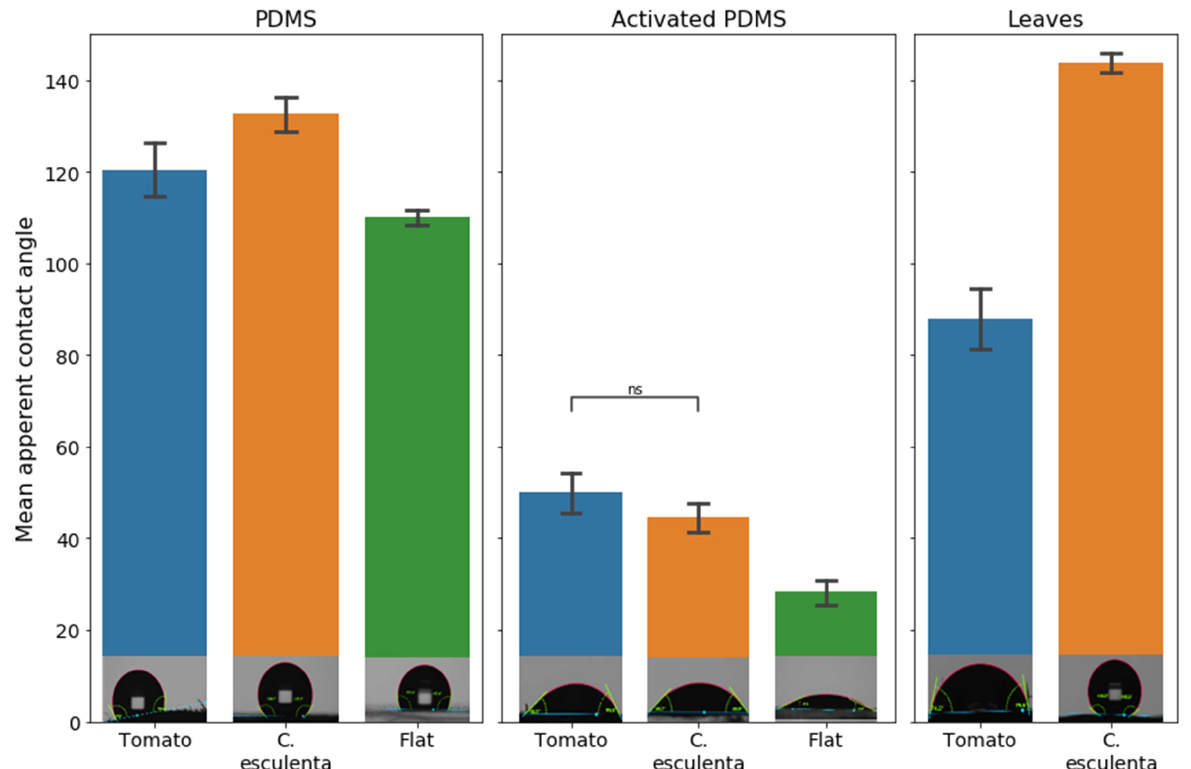
Figure 4. Hydrophobicity measurements of natural and synthetic surfaces. The mean apparent contact angle of synthetic and natural surfaces was measured. The bottom row presents images of the drop in a stable state. The drop spreads on hydrophilic surfaces (for example, surfaces in the middle section) and does not do so on hydrophobic surfaces (for example, surfaces in the left section). Pairs comparison was conducted using Welch’s t -test, α was adjusted using Bonferroni correction. The mean contact angle of PDMS replicas is significantly higher than the mean contact angle of activated PDMS surfaces ( p < 0.001) for all structures under consideration. The surface contact angle of synthetic surfaces (PDMS, activated PDMS) are significantly larger than chemically identical flat surfaces (flat) ( p ≤ 0.04). Contact angle measured on C. esculenta leaf (143.7° ± 4.4°) is significantly higher than the contact angles measured on tomato leaf (87.9° ± 13.3°) with p ≤ 0.00001.